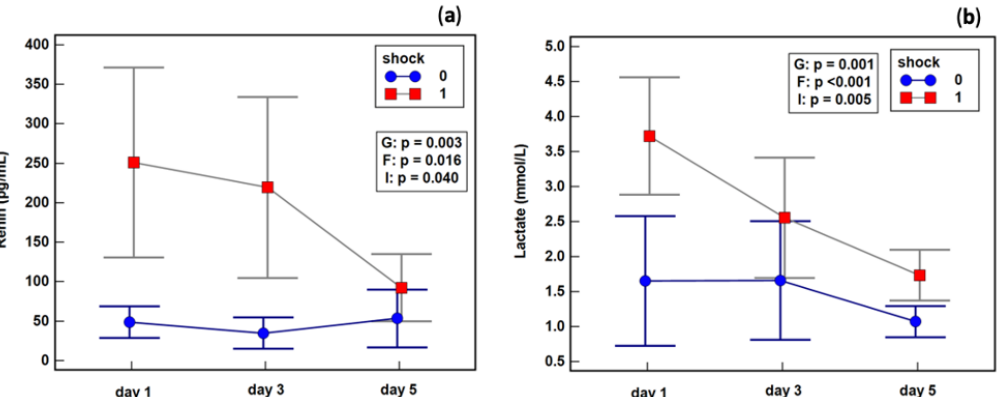
Figure 5. Effect of septic shock on the dynamics of ( a ) renin; ( b ) lactate. Legend: 0—patients without septic shock, 1—patients with septic shock. Notes: Data were analyzed using repeated measures ANOVAs, and are presented as means (red squares and blue dots) with 95% confidence intervals (gray and blue whiskers). G, the group effect (survivors vs. non-survivors); F, the factor effect (day of testing); I, group and factor interaction.